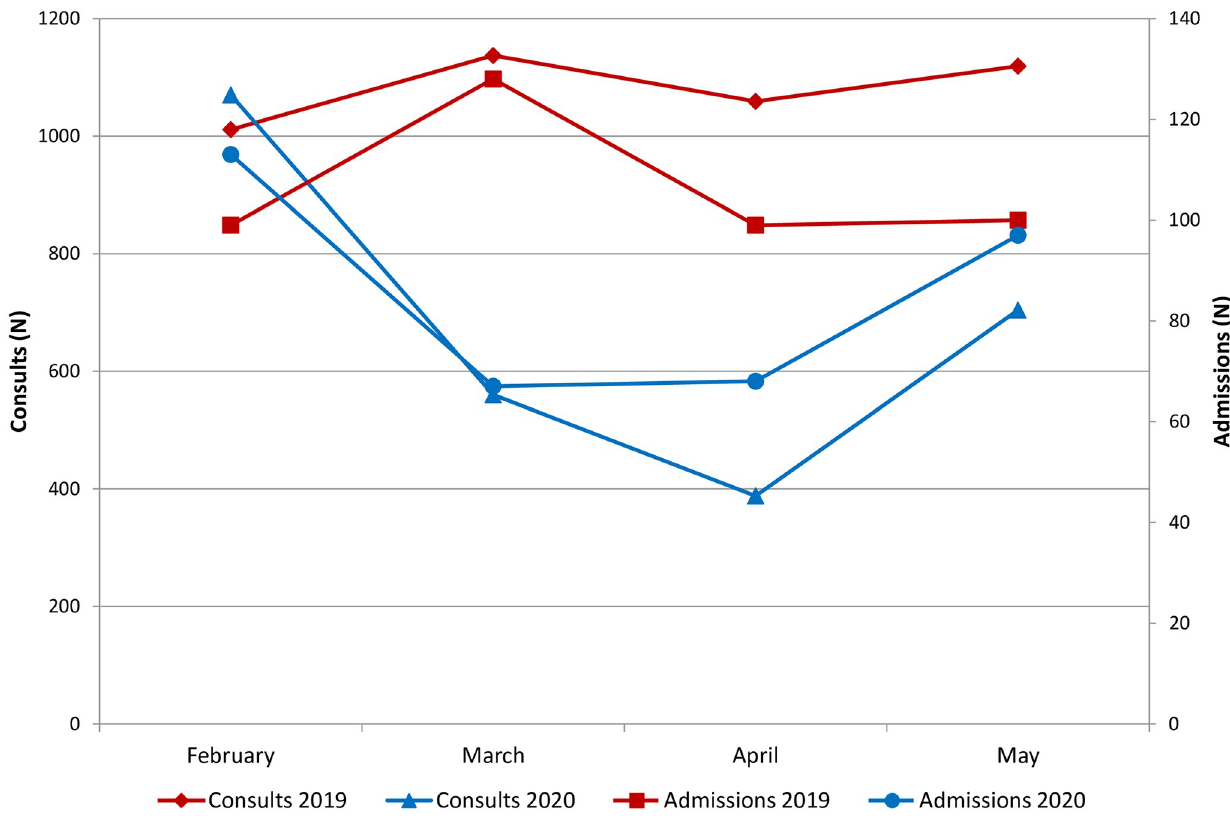
Fig 1. Emergency surgery consults and admissions. Monthly evolution of unplanned general surgery consults and admissions during two periods: 02-05/ 2019 (pre-pandemic) and 02-05/2020 (COVID19 pandemic). https://doi.org/10.1371/journal.pone.0252919.g001 PLOS ONE | https://doi.org/10.1371/journal.pone.0252919 June 18,